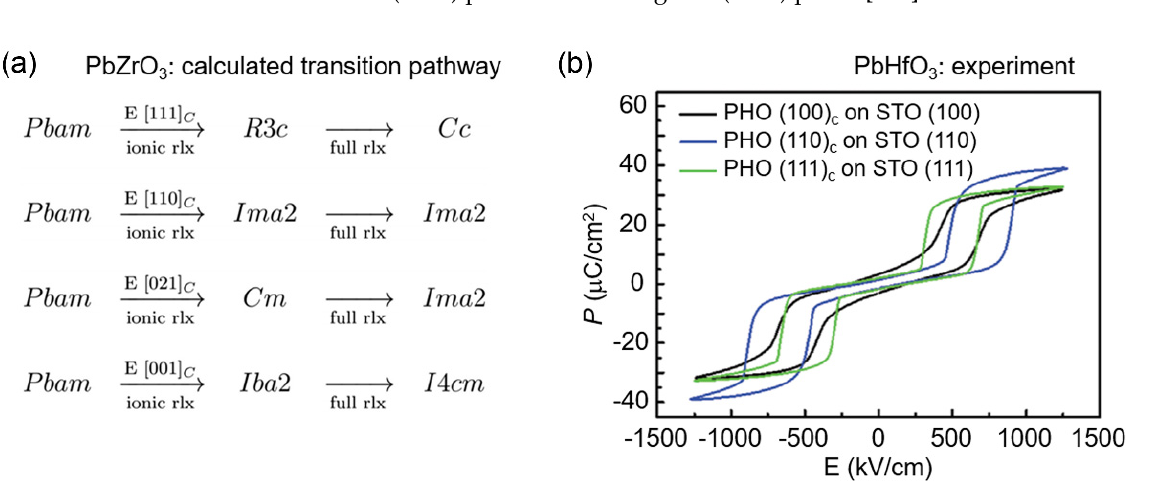
Figure 5. Anisotropic energy storage pathways. ( a ) Predicted phase transition pathways for PbZrO 3 associated with ionic and full structural relaxation after applying electric fields along different crystallographic directions. The multiscale structure prediction combines classical and first-principles density functional theory [114]. ( b ) Structural anisotropy-dependent energy storage performance of AFE PbHfO 3 thin films grown on different crystal-plane-terminated SrTiO 3 substrates [71].